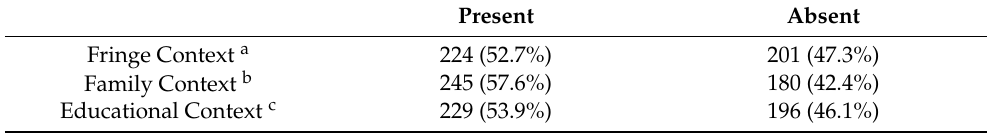
Table 6. Distribution of the sample according to the context for juvenile delinquency.